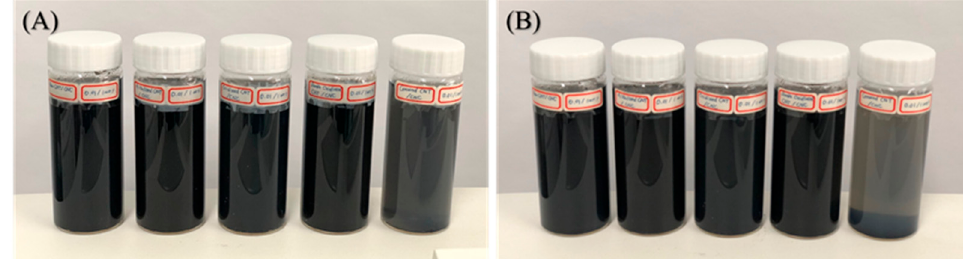
Figure 8. Photographs of the nanofluids ( A ) before 21 days ( B ) after 21 days (RCNTs–CNC, ACNTs– CNC, OCNTs–CNC, DOCNTs–CNC, and GCNTs–CNCin sequence left to right).